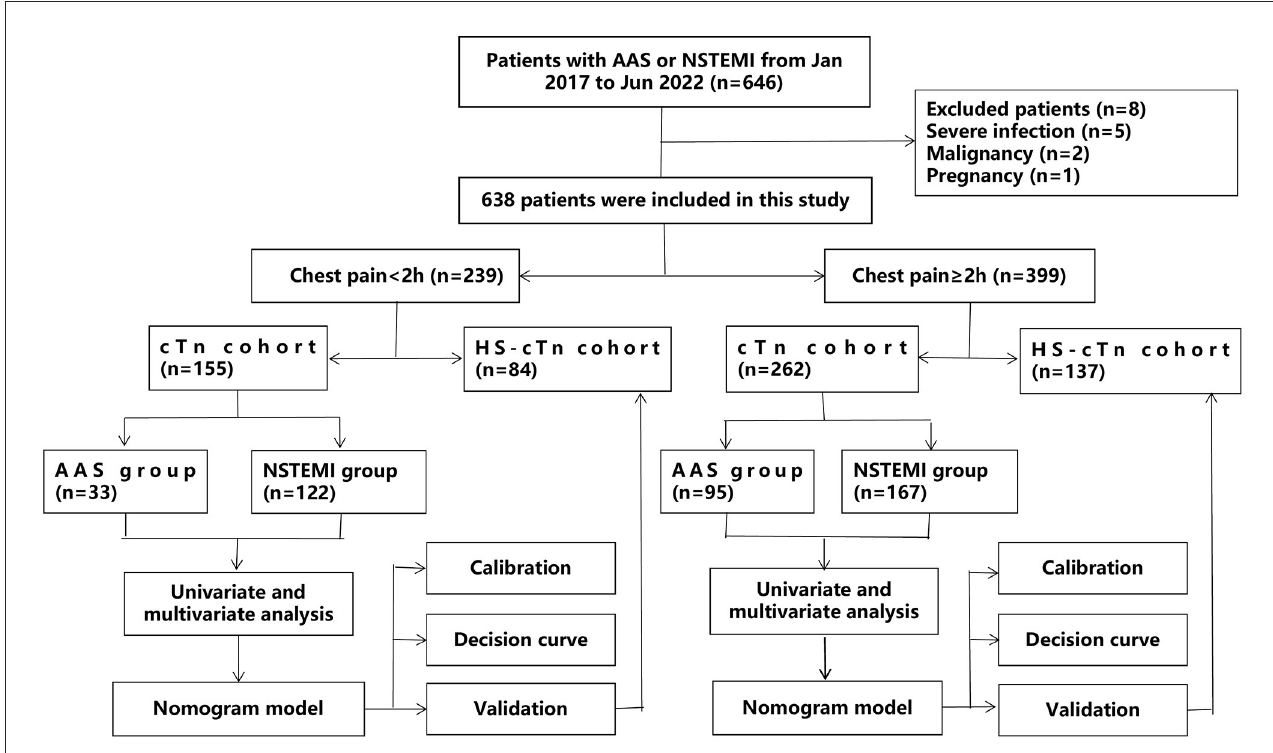
FIGURE1 A flow diagram of the overall study design. AAS, acute aortic syndrome; HS-cTn, high-sensitivity cardiac troponin; NSTEMI, non-S T- elevation myocardial